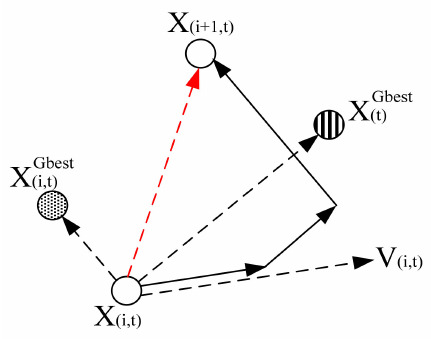
Figure 1. Searching orientation of the ith particle in